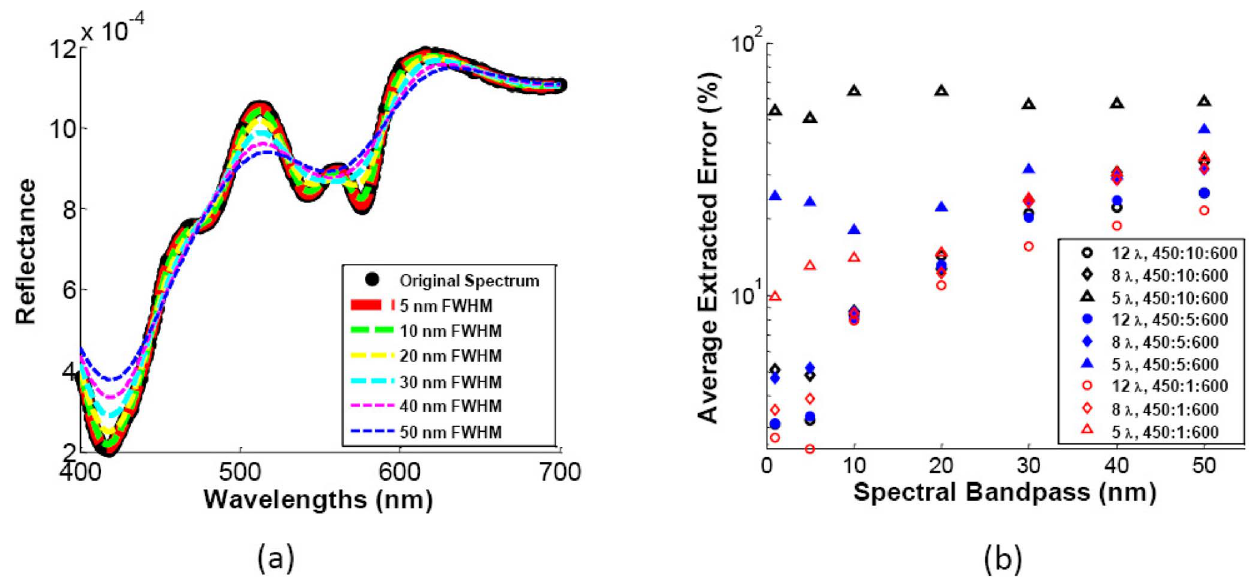
Figure 5. Effect of increasing spectral bandpass. (a) Simulation of the effect increasing spectral bandpass on a diffuse reflectance spectrum representing 10 m M [THb], 5.5 m M [ b c], and 3.11 avg , m s ’ . . (b) Average extracted errors of [THb], [ b c], avg , m s ’ . with increasing spectral bandpass.